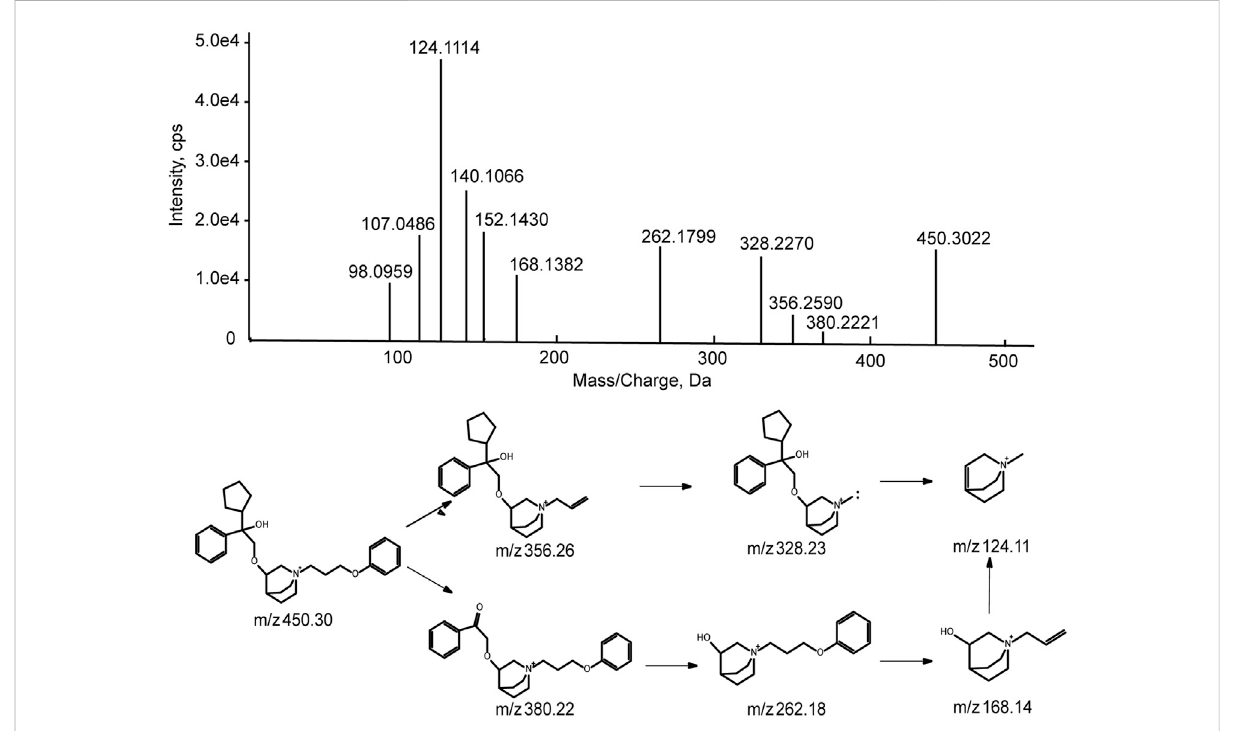
FIGURE 5 Accurate MS/MS spectra of 101BHG-D01 and its proposed fragmentation